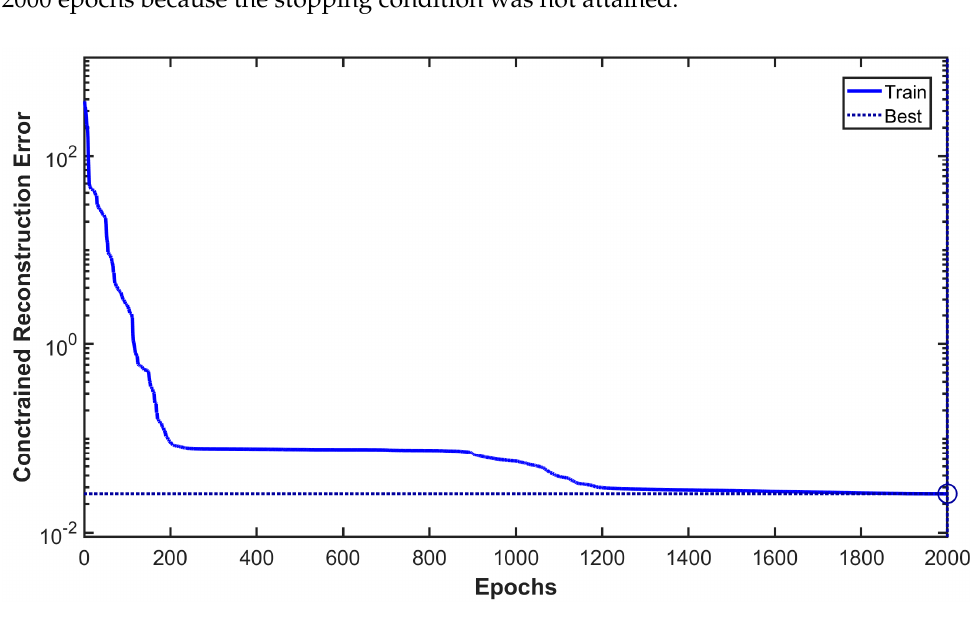
Figure 9. The reconstruction performance of the SAE, which was utilized for sample dataset augmentation in this study.